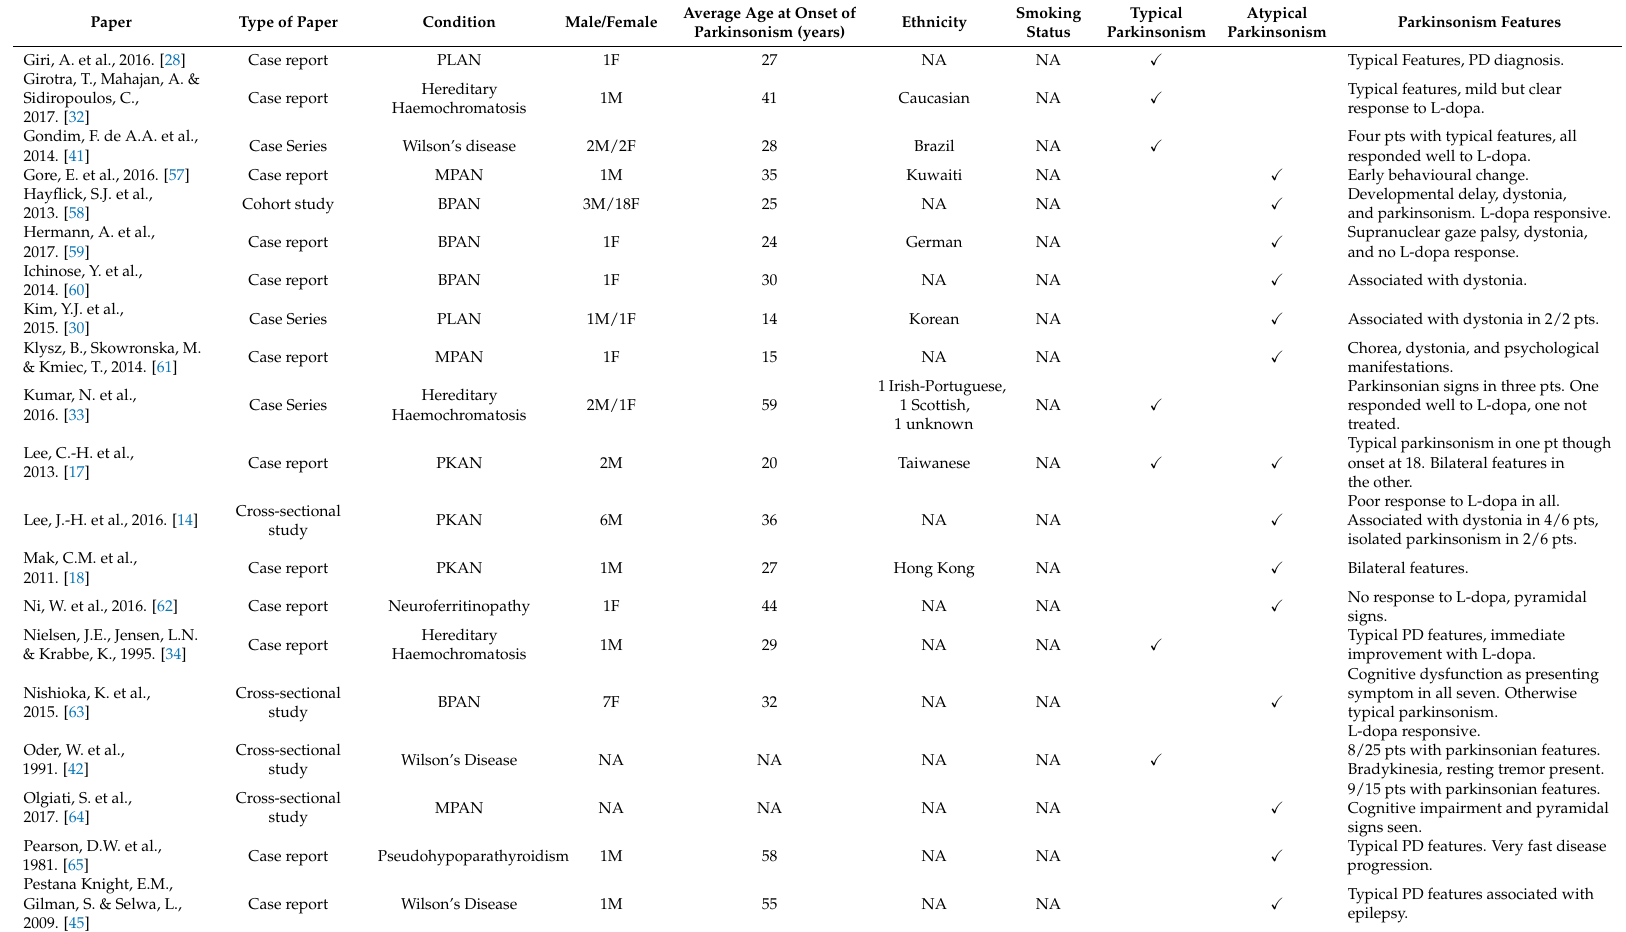
Girotra, T., Mahajan, A. & Typical features, mild but clear Hayflick, S.J. et al., Developmental delay, dystonia,